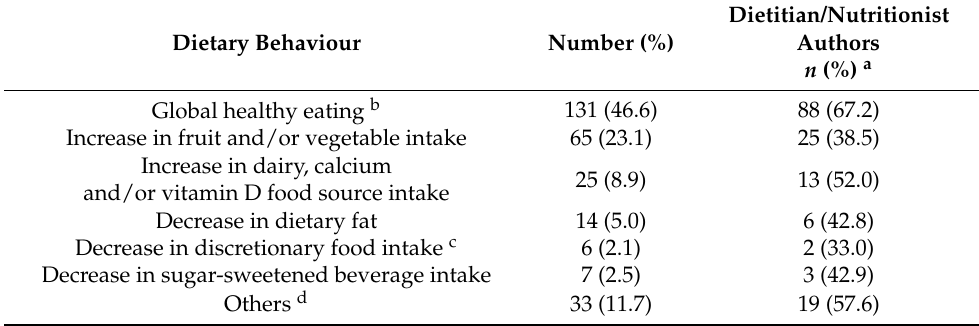
Table 1. List of nutrition behaviours addressed by the studies. Some interventions include more than